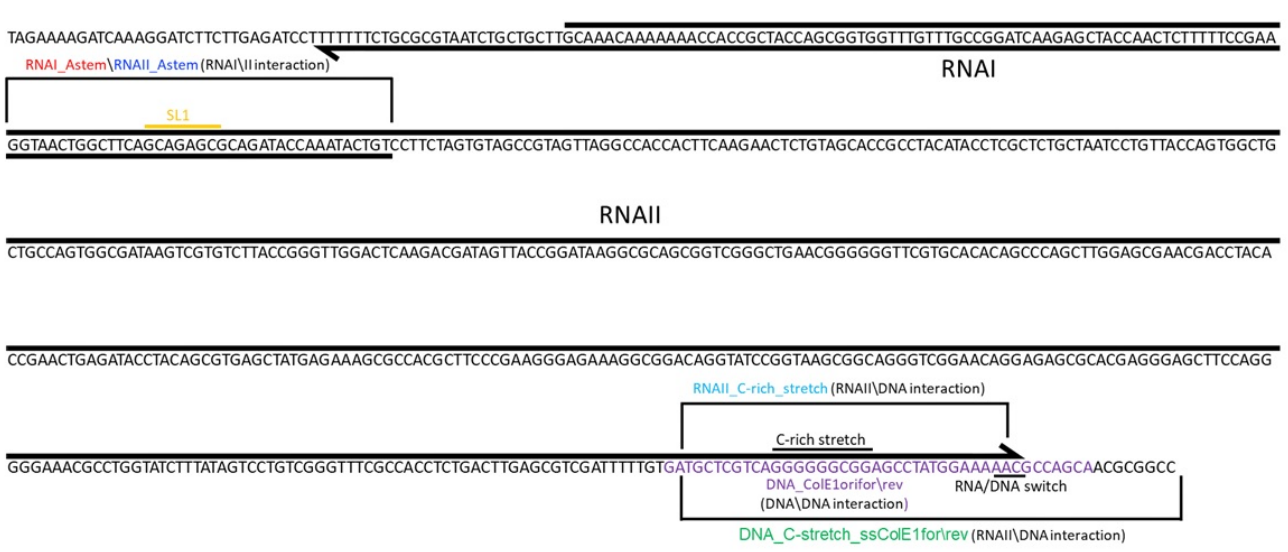
Figure 2. Nucleotide sequence of the replication origin region of the ColE1 plasmid. Regions coding for RNA I (RNAI) and RNA II (RNAII) transcripts are indicated by thick arrows, with arrowheads indicating the direction of transcription. RNA secondary structures are shown in Section 3.3. Regions corresponding to RNA and DNA oligonucleotides used in this work are indicated by brackets. Colors correspond to colors of oligonucleotides used in this work, as listed in Section 2.3. Structures and NA fragments crucial for ColE1 plasmid DNA replication (SL1, stem-loop 1; C-rich stretch; RNA/DNA switch) are indicated.